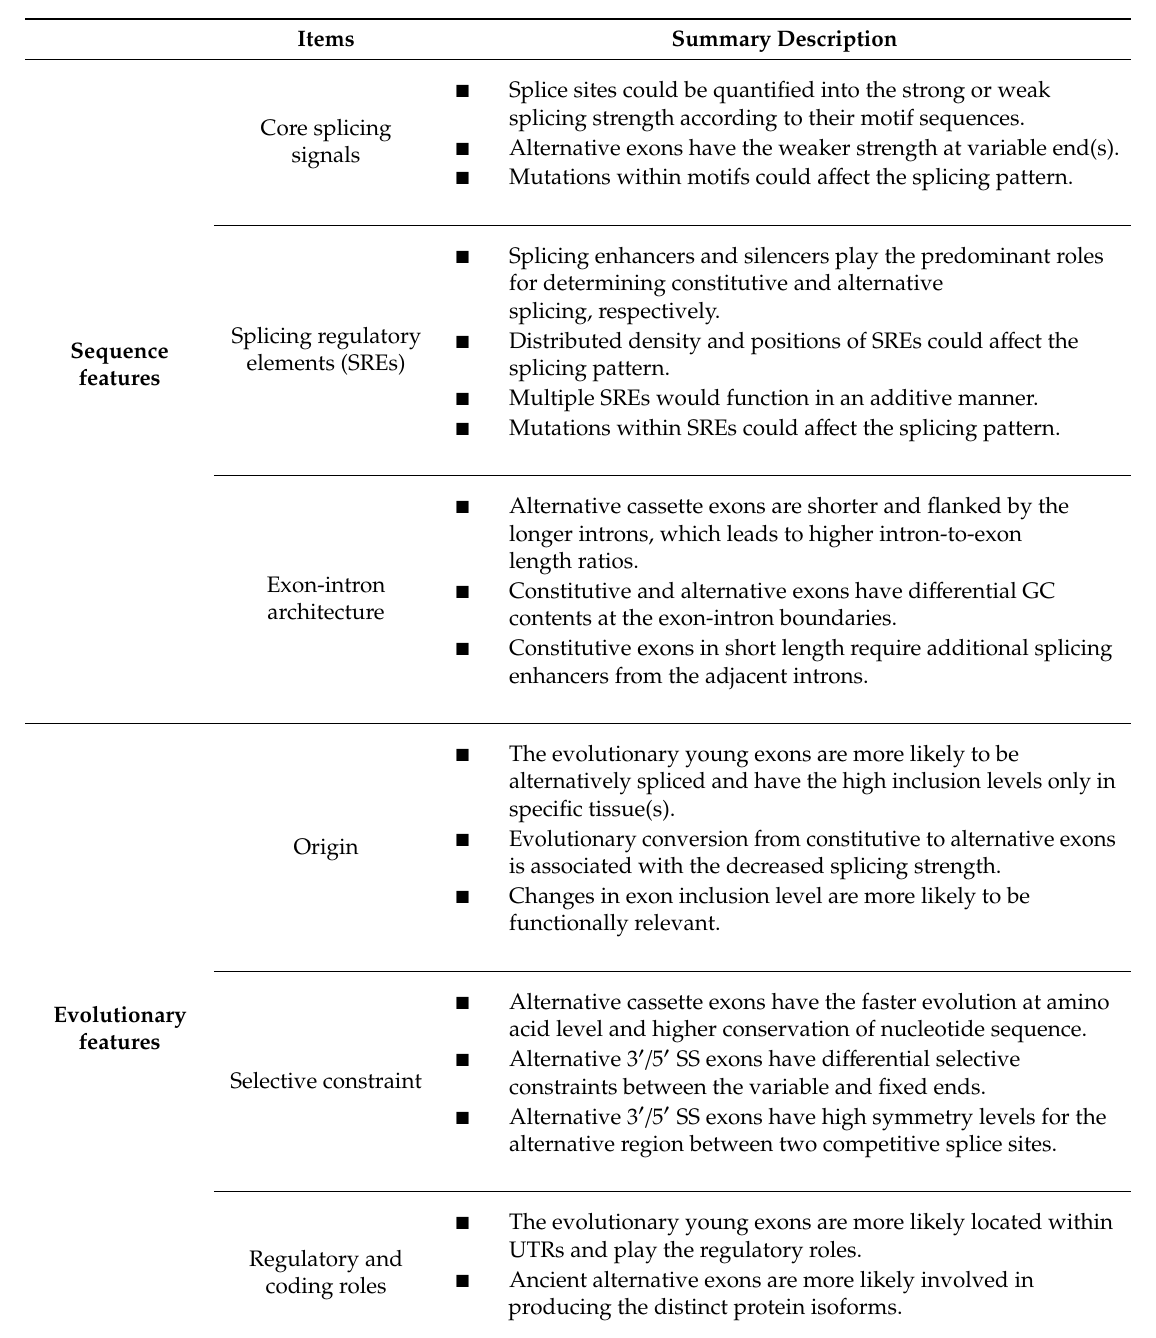
Table 1. Summary of sequence and evolutionary